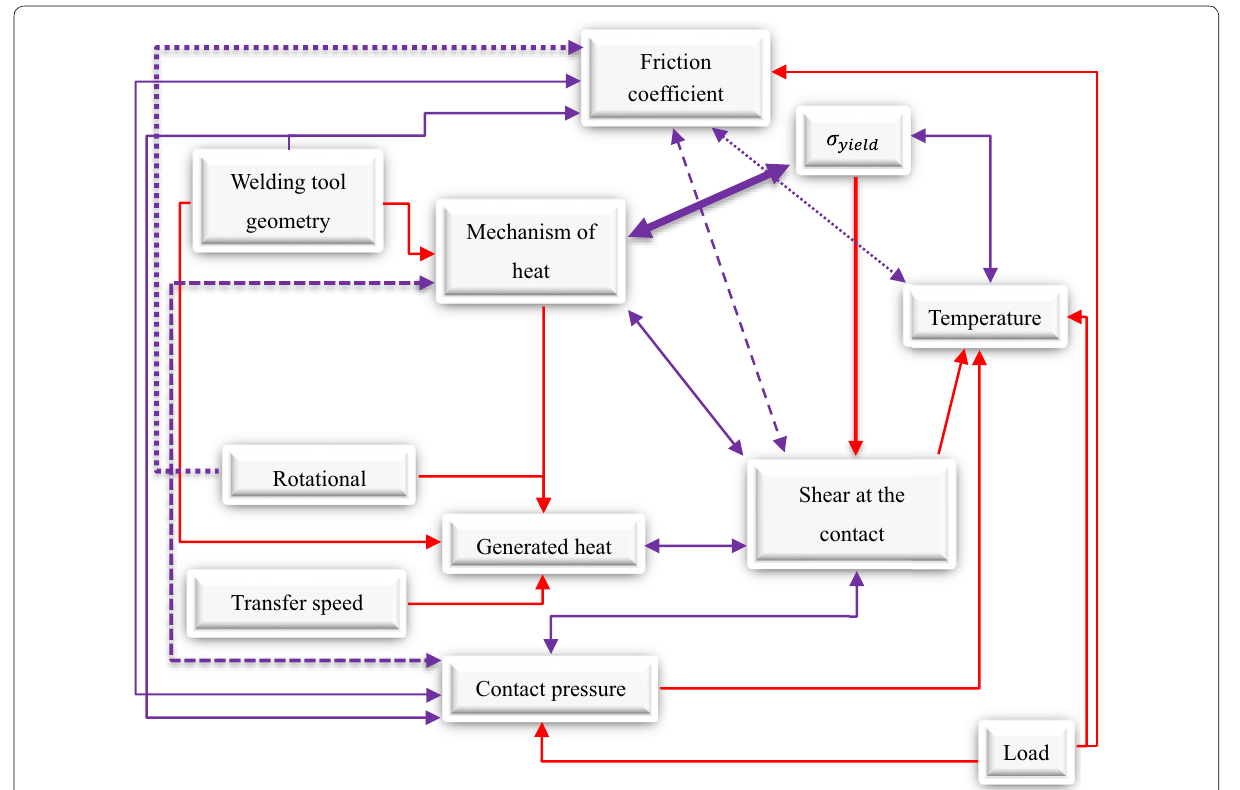
Figure 2 Flowchart of the coupled temperature displacement behavior during